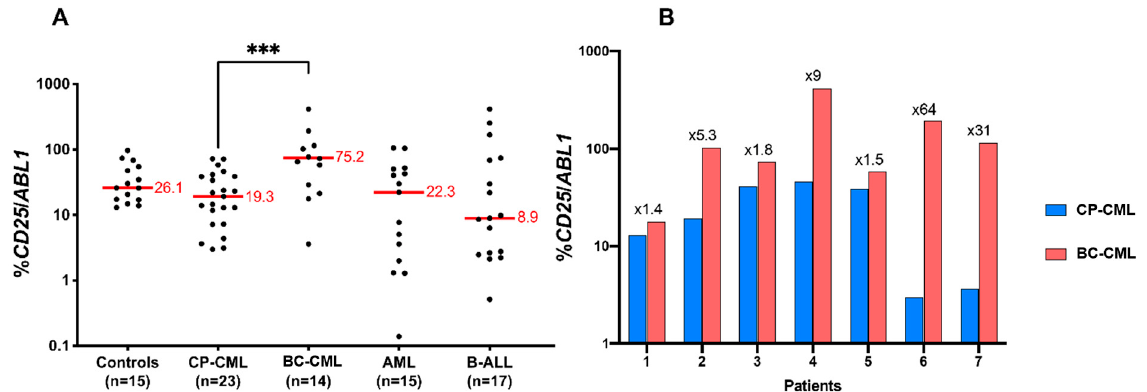
Figure 8. CD25 expression in CP-CML, BC-CML, AML, and ALL patients. ( A ) CD25 is overexpressed in BC-CML patients. The scatter dot plot shows the CD25 mRNA expression in CML patients in the chronic phase at diagnosis and patients in the acute phase compared with healthy donors and patients with acute leukemias. For each group, the median is shown in red. p -value was calculated by the two-sided Mann–Whitney test. The three (***) asterisks indicate a p value < 0.001. ( B ) CD25 mRNA levels are increased in all CML patients who progressed to an acute phase. The interleaved bar diagram shows the evolution of the CD25 mRNA expression in 7 patients who were analyzed at the chronic and blast phases. CD25 expression is shown in a logarithmic (Log10) scale, and the multiplication coefficient between the two phases is shown. Two data points are outside the axis limits (>1000).